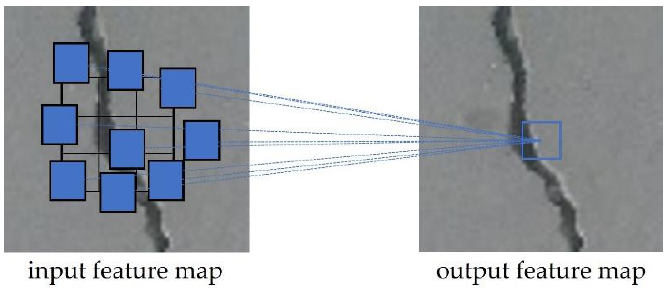
Figure 6. Description image of the deformable convolutional network.